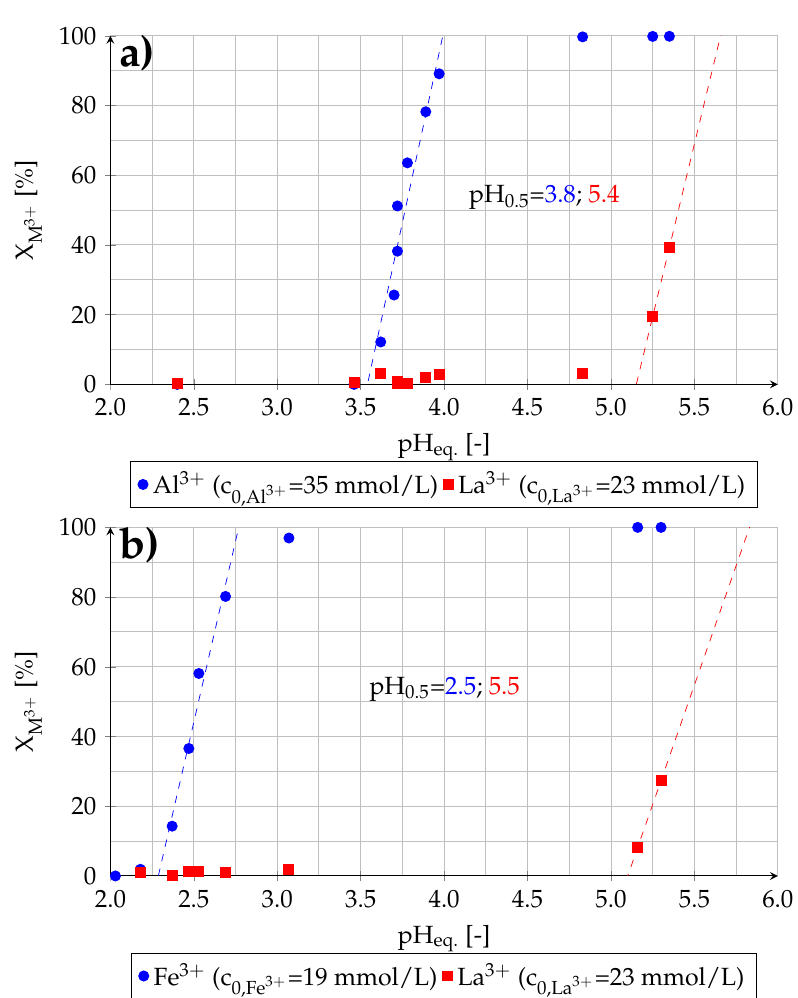
Figure 8. Removal of ( a ) aluminum and ( b ) iron from binary-component solutions by solvent extraction (experiment (4)